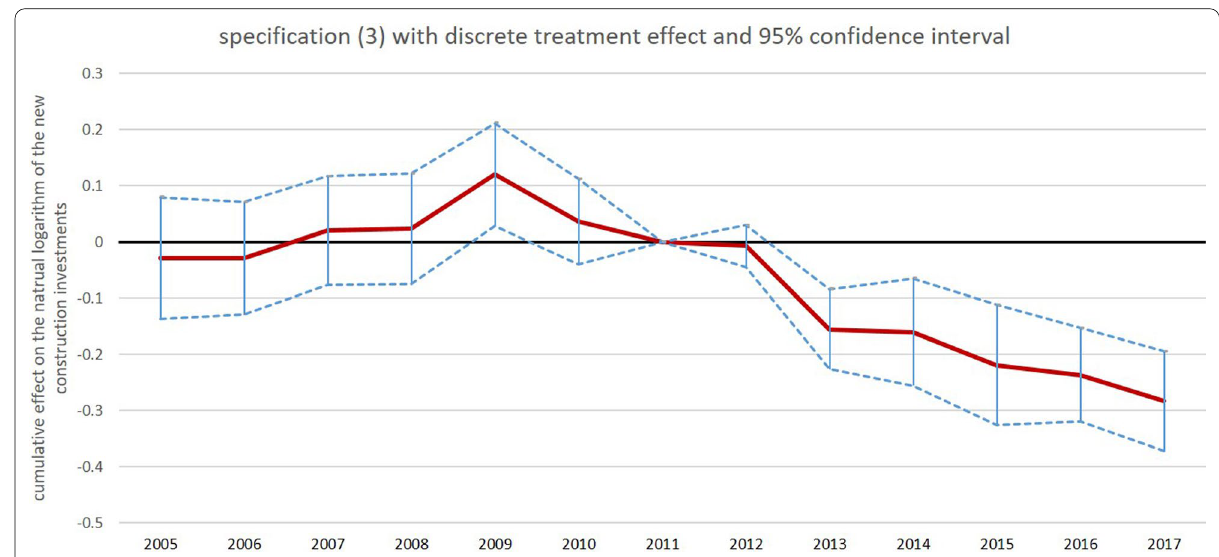
Fig. 3 Cumulative returns of the discrete treatment model before and after the second home law. Source : Author’s illustration of the obtained results